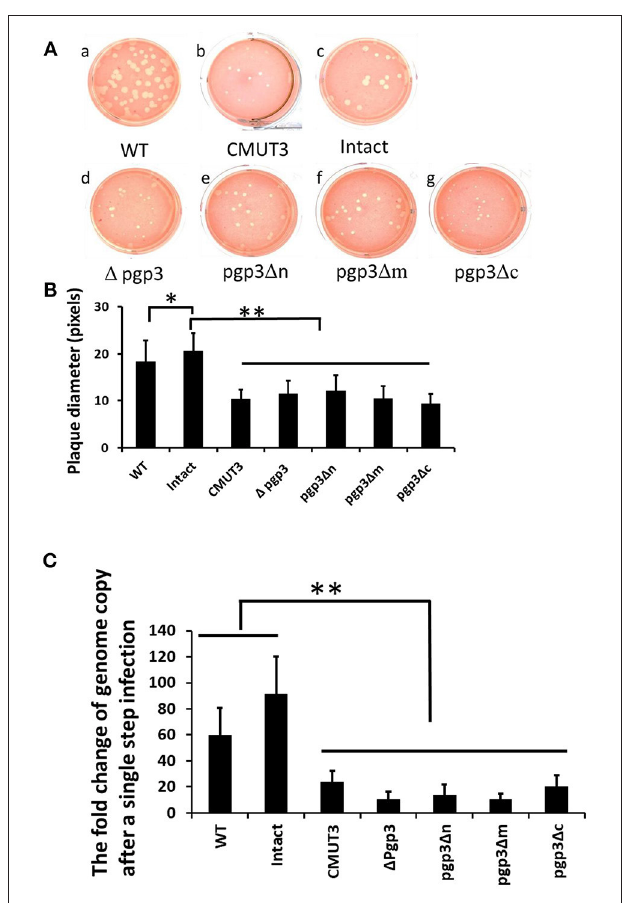
FIGURE 4 | Effect of Pgp3 domain deletion on chlamydial growth in vitro . (A) Wild-type C. muridarum (WT, a); plasmid-free C. muridarum (CMUT3, b); CMUT3 transformed with pGFP::CM (intact, c) or pGFP::CM with pgp3 full-length deletion ( 1 pgp3, d), pgp3 N-terminus deletion (pgp3 1 n, e), pgp3 middle domain deletion (pgp3 1 m, f), or pgp3 C-terminus deletion (pgp3 1 c, g) was stained with neutral red after inoculation onto McCoy cell monolayers in 12-well plates for 5 days. (B) Plaque sizes were measured in pixels using PlaqueDetector. Plasmid-free CMUT3, 1 pgp3, pgp3 1 n, pgp3 1 m, and pgp3 1 c produced significantly smaller plaques (* P < 0.05, ** P < 0.01; Student’s t -test). (C) qPCR was used to measure the changes of genomic copy number of these strains after a single step infection. The growth rates of pgp3-domain-deficient transformants and plasmid free CMUT3 were significantly lower than those of WT or intact C. muridarum (** P < 0.01; Student’s t